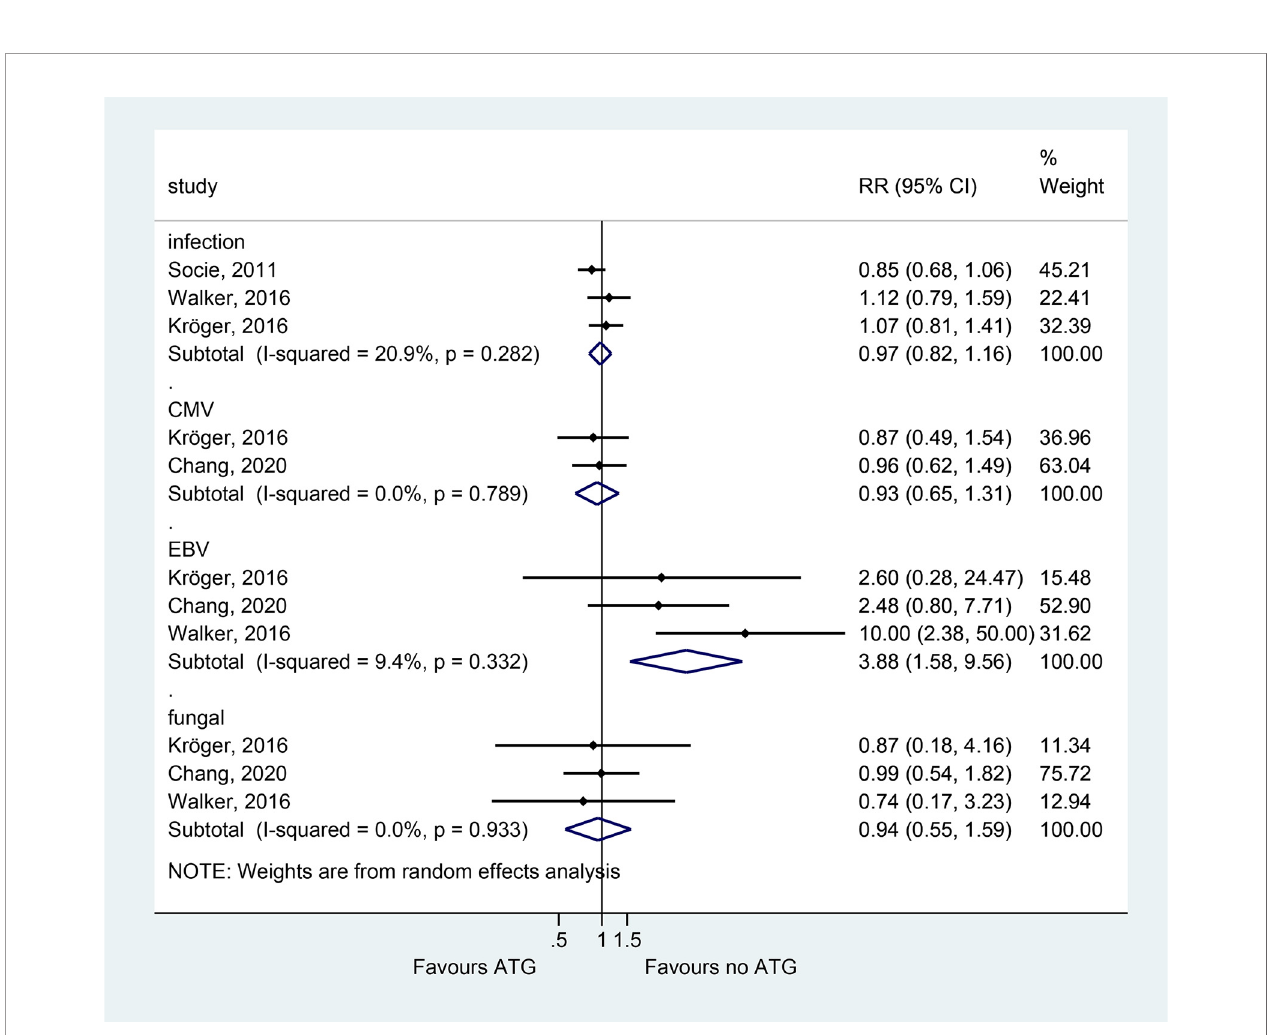
FIGURE 5 | Forest plot for infection